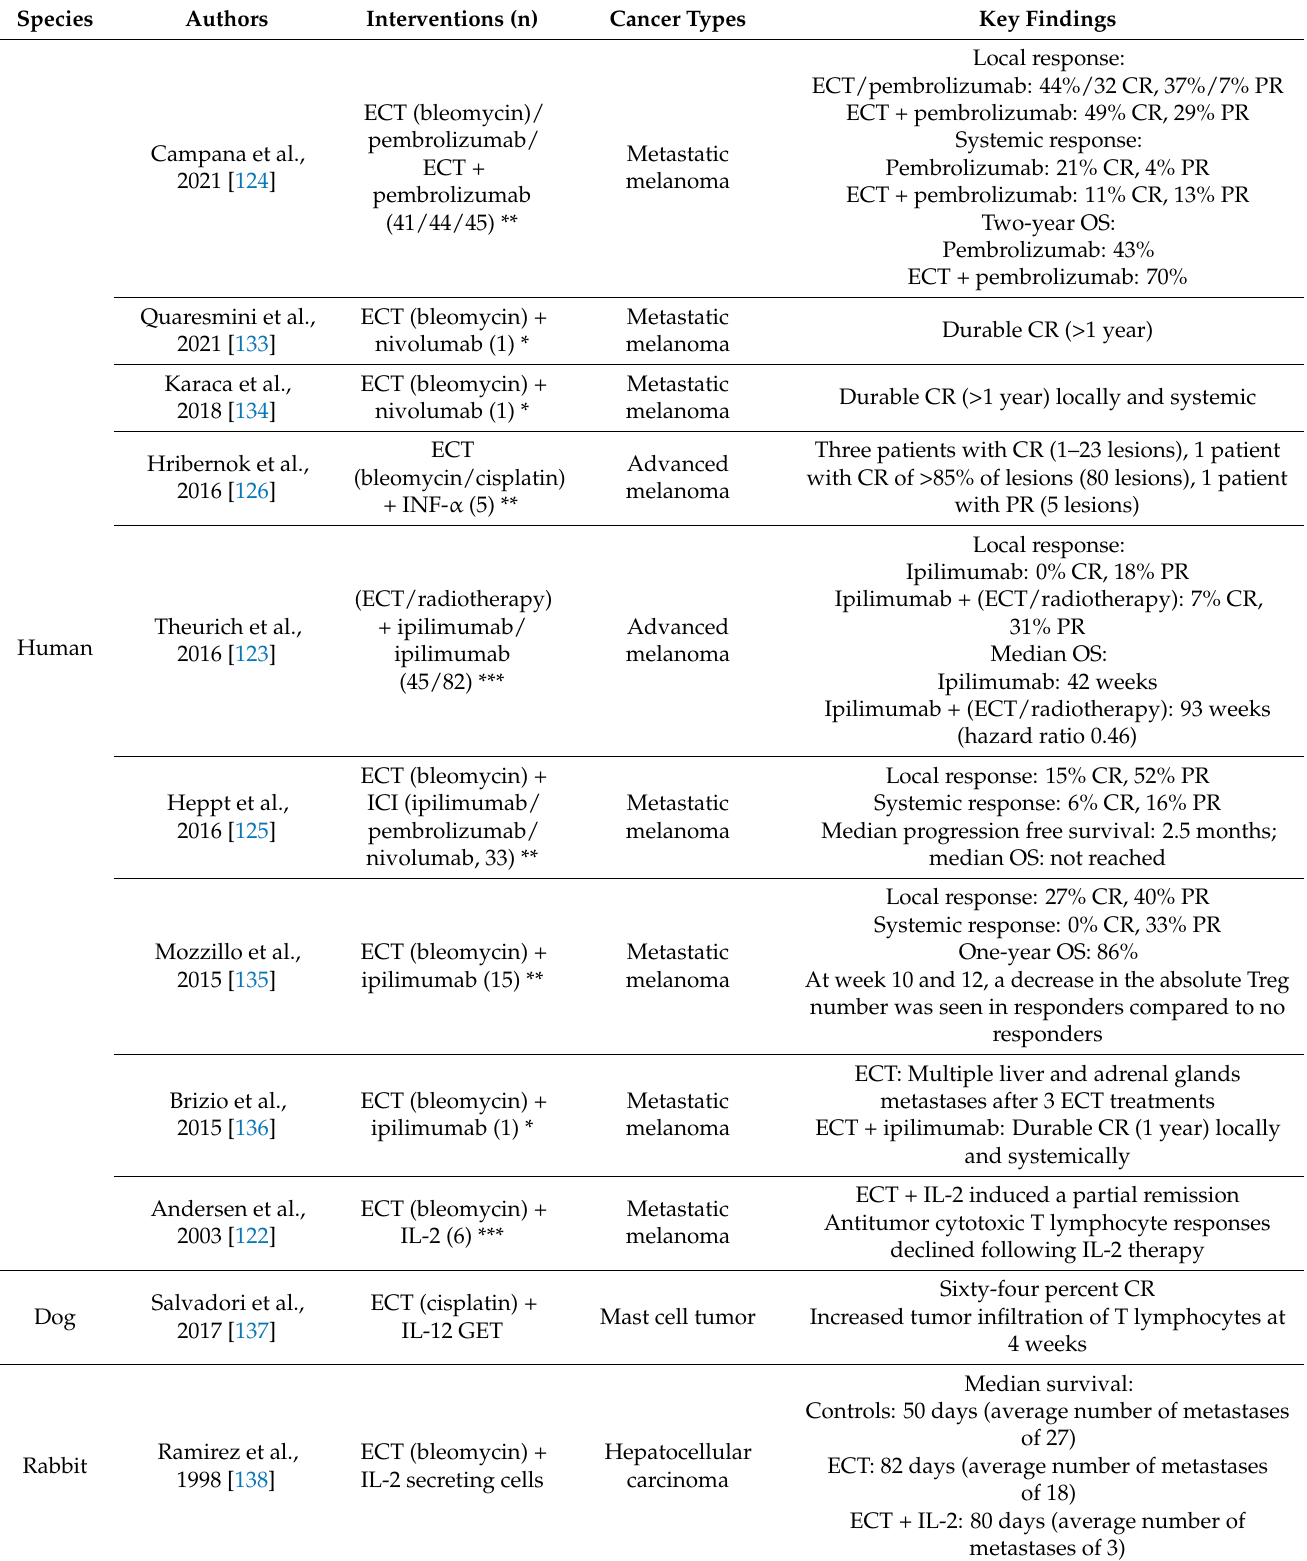
Table 3. Summary of ECT + immunotherapy